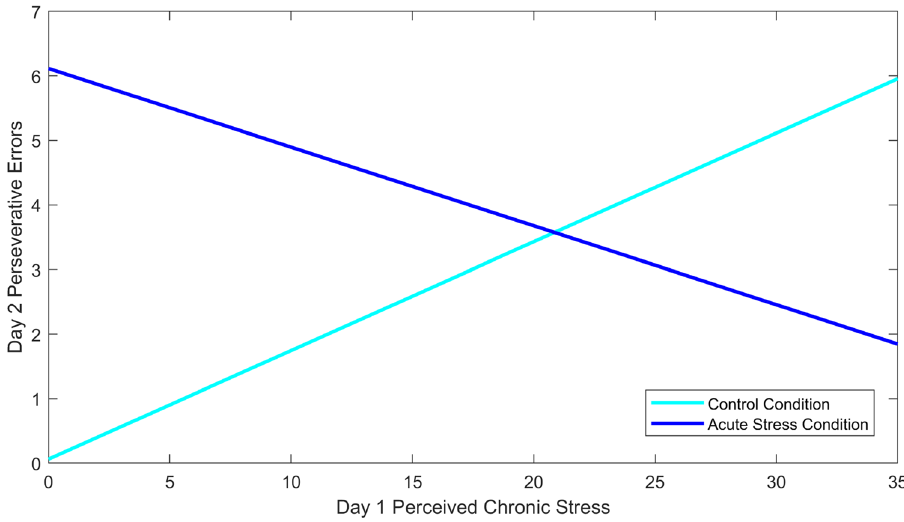
Figure 7. Effect of acute stress condition and day 1 perceived stress score on perseverative errors during the Wisconsin Card Sorting Test; figure includes all participants (n control = 16, n stress =